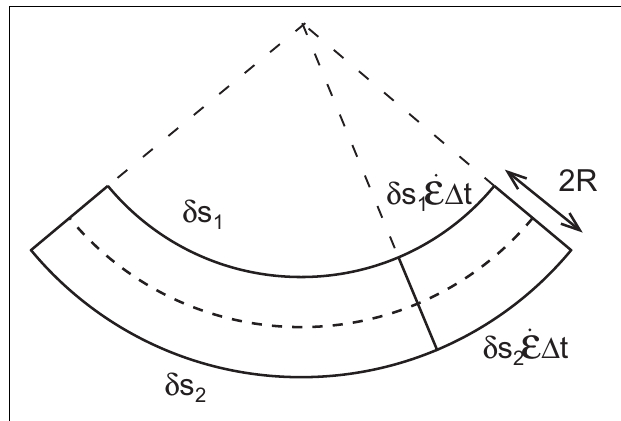
FIGURE 4 | An element of a curved organ is elongating with the same growth rate ˙ (cid:3) on each side. The increment of length does not affect the curvature of the organ but the final orientation of the element is